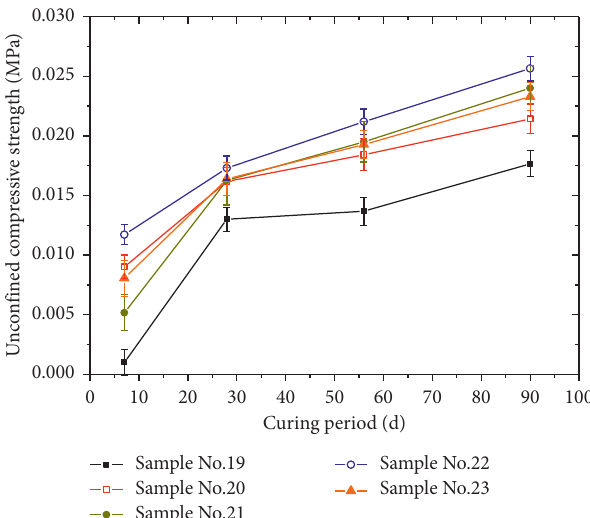
Figure 14: Influence of curing period on UCS of samples stabilised with Na